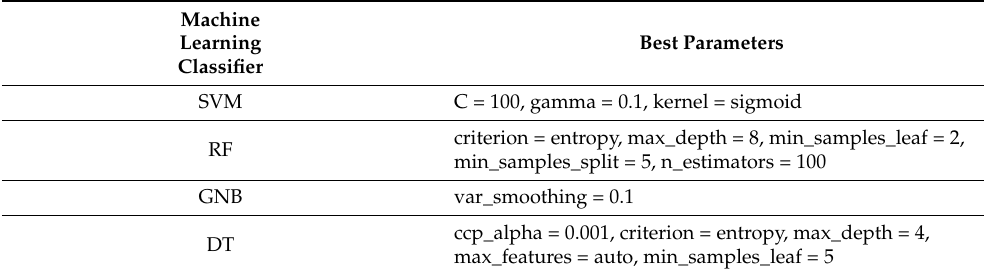
Table 9. Machine learning classifiers with their optimized parameters after hyperparameter